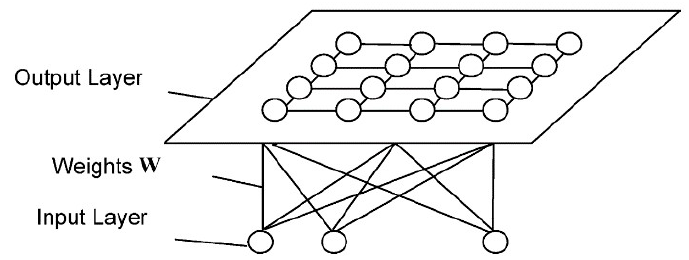
Figure 10. The normal structure of a Kohonen neural network (KNN).